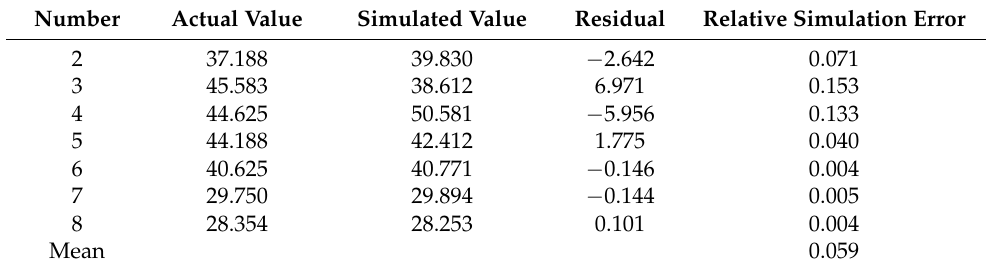
Table 10. Simulation error check of GM (0, 5) model for compressive strength.